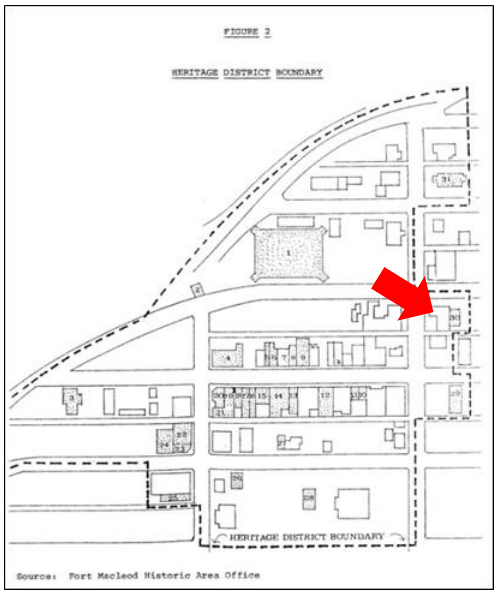
Figure 3: Fort Macleod Provincial Historic Area boundary map. Source: HRM